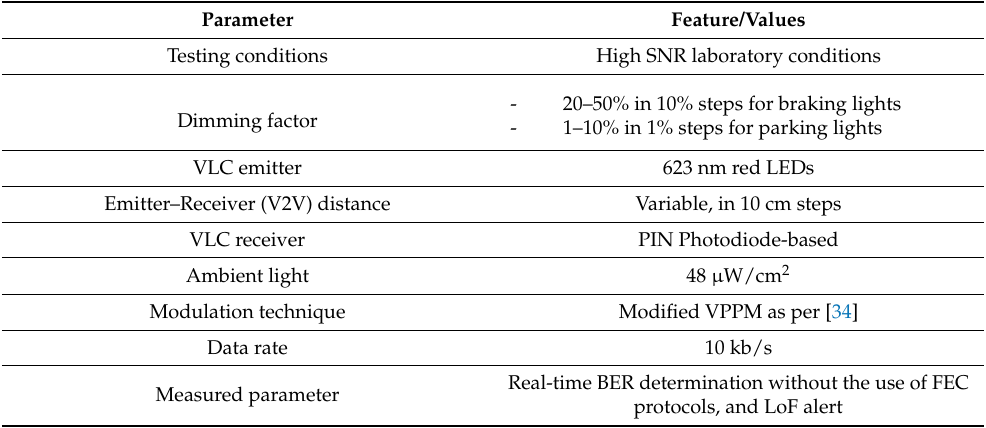
Table 4. Summary of the experimental parameters.